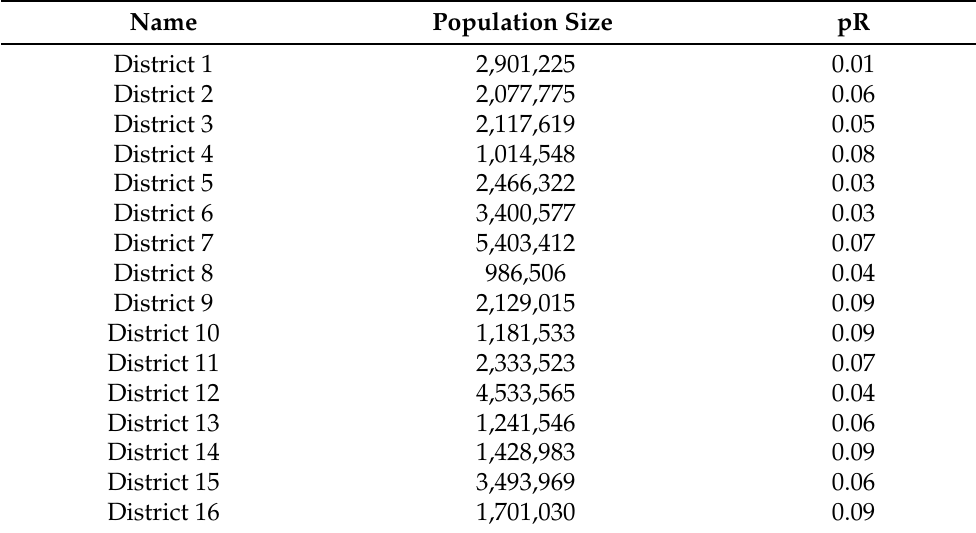
Table 4. Assumed territorial division.